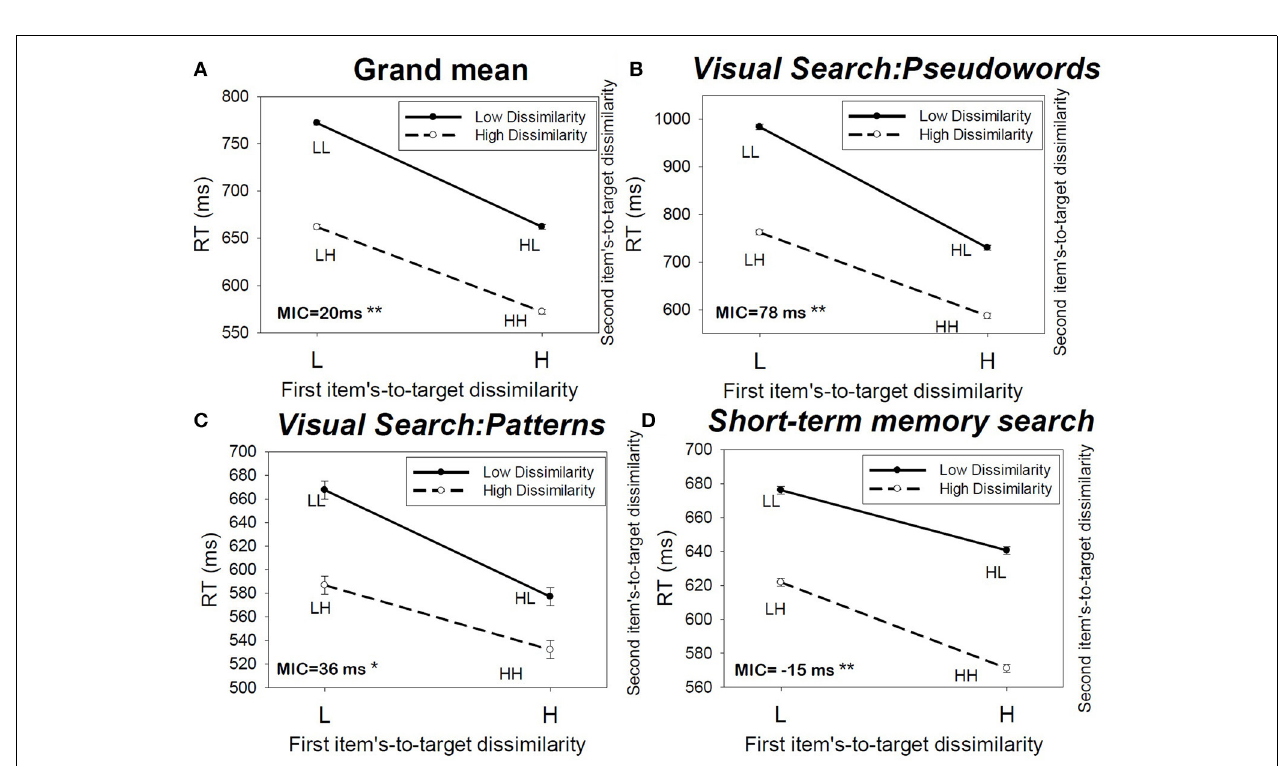
FIGURE 3 | (A) Mean RT averaged across the subjects, and (C,D) the MIC test results for different experimental conditions.